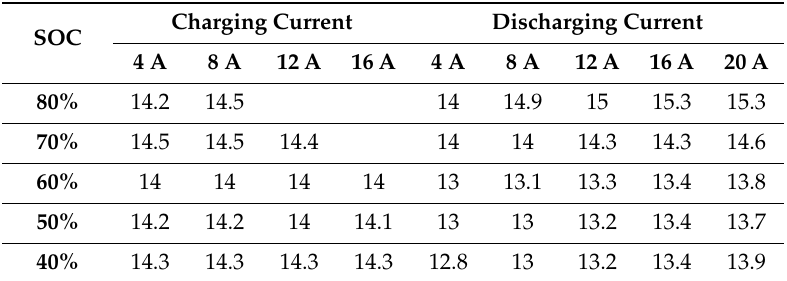
Table 2. Calculated lumped resistance of the battery’s cell. Unit: [m Ω ].